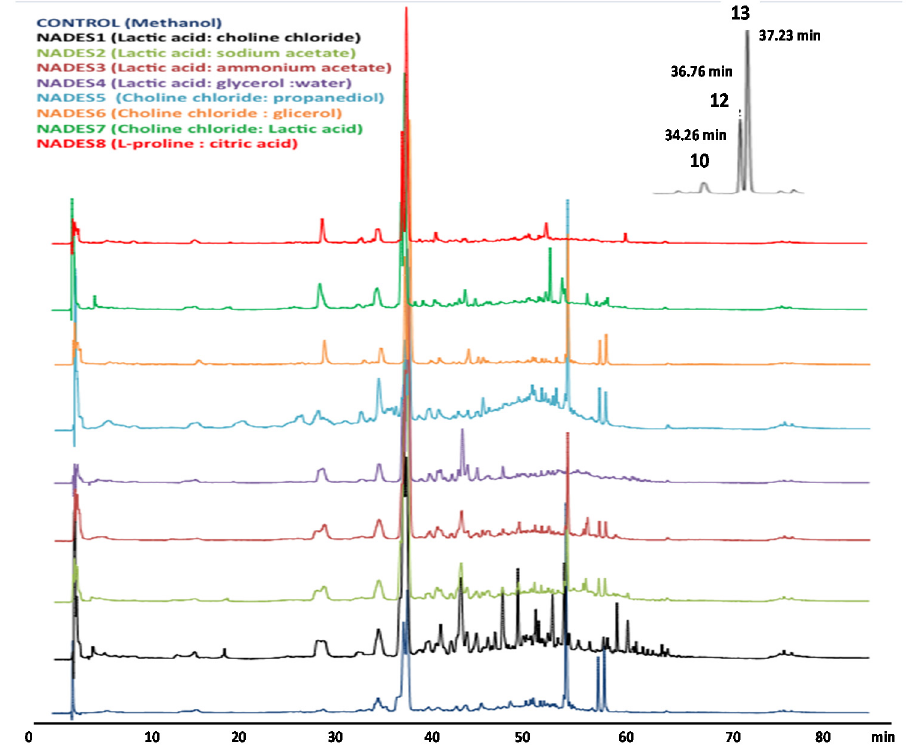
Figure 6. HPLC-UV chromatogram (320 nm) of phenolic compounds from Buddleja globosa leaves extracted with different NADES solvents. Peaks 10 (Rt = 34.26 min), 12 (Rt = 36.76 min), and 13 (Rt = 37.23 min) correspond to luteolin 7- O -glucoside, forsythoside B and verbascoside, respectively.